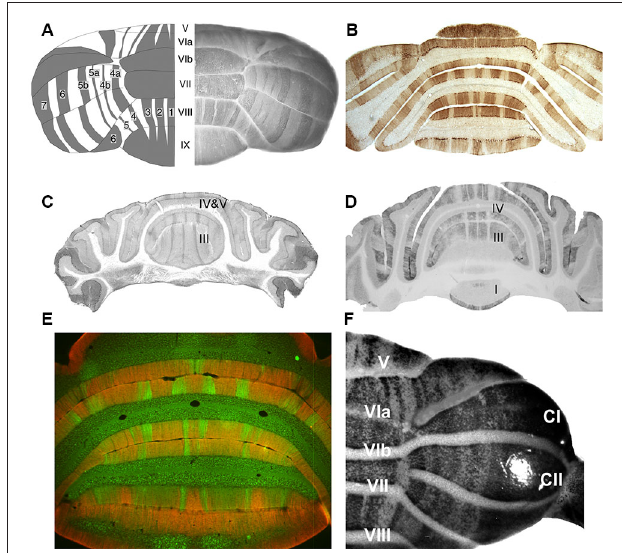
FIGURE 1 | Stripes in the adult mouse cerebellar cortex as revealed by various Purkinje cell subset markers . (A) On the right is a whole mount dorsal view of a hemicerebellum immunoperoxidase stained for zebrin II/aldolase C. On the left is a cartoon view: lobules are numbered with Roman numerals (V–IX); zebrin II+ stripes as 1–7 (Adapted from Furutama et al., 2010). (B) A transverse section through the posterior lobe immunoperoxidase stained by using anti-zebrin II (Adapted from Marzban et al., 2004). (C) A transverse section through the anterior lobe immunoperoxidase stained for phospholipase C β 3 (PLC β 3) (Adapted from Sarna et al., 2006). (D) A transverse section taken close to that in panel C, immunoperoxidase stained for PLC β 4 (Adapted from Sarna et al., 2006). (E) Transverse section through the posterior lobe double immunofluorescence labeled for GABA type B receptors 2 (GABA B R2) (red) and PLC β 4 (green) (Adapted from Chung et al., 2008). (F) A whole mount dorsal view of a hemicerebellum from an IP 3 R1nls-lacZ transgenic mouse X-gal stained for transgene expression (Adapted from Furutama et al.,